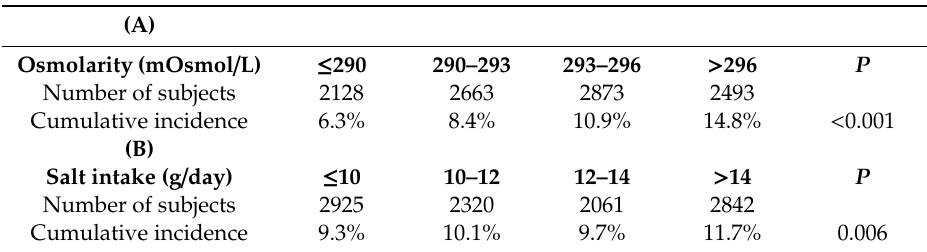
Table 2. Cumulative incidence of hypertension over five years among quartiles of serum osmolarity ( A ) and among quartiles of salt intake ( B ).